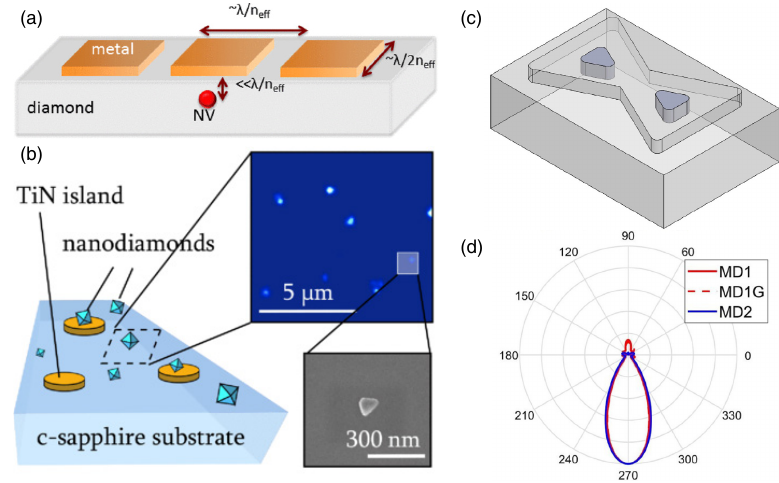
Figure 3. Radiative lifetime engineering with plasmonic devices. Recent examples of plasmonic device geometries include: ( a ) a shallow NV center situated below an optical plasmonic antenna; ( b ) nanodiamonds containing NV ensembles deposited over TiN plasmonic resonators; and ( c ) a hybrid dielectric-metal hourglass structure designed to couple to a shallow NV. Panel ( d ) shows the highly directional angular emission distribution that results from hybrid hourglass plasmonic devices (the device shown in (c) is labeled MD2). “MD” stands for metal-dielectric. See [91] for details on the design variations in (d). Panel (a) is reprinted with permission from [76]. Copyright 2015 by the American Physical Society. Panel (b) is reprinted with permission from [92]. Copyright 2017 by the American Physical Society. Panels (c,d) are from Karamlou et al.